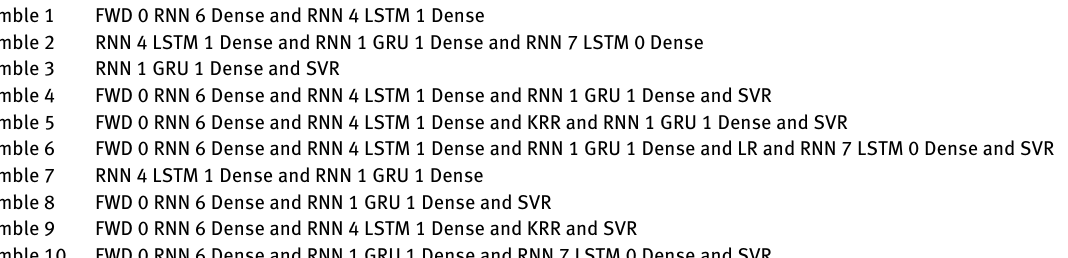
Table 11: Top Ensembles. Ensemble 1